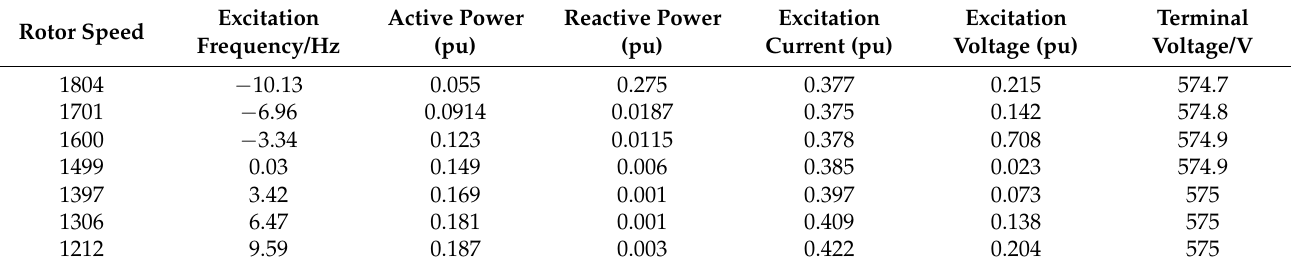
Table 3. The change in rotor speed at a given power at a wind speed of 8 m/s.